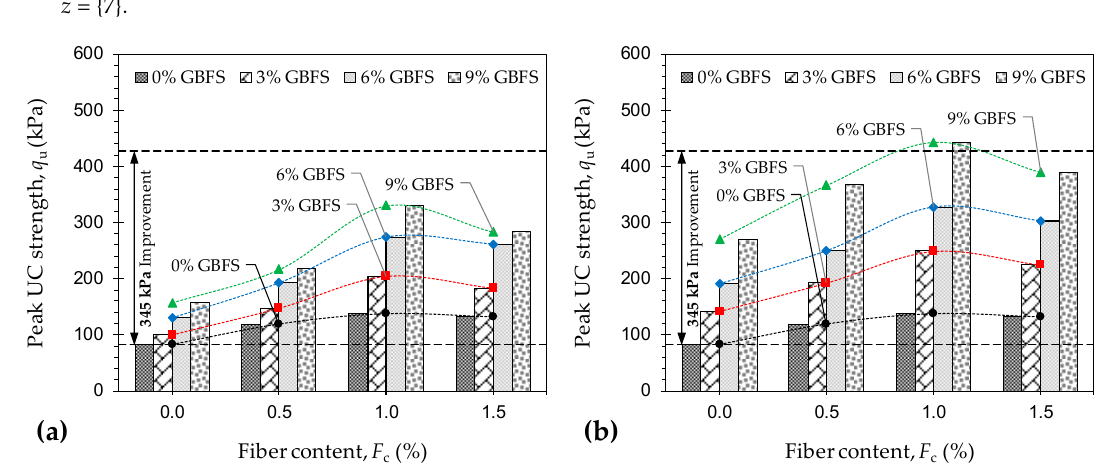
Figure 5. Variations of peak UC strength q u against JF content for the natural soil and various GBFS-treated samples: ( a ) T c = 7 days; and ( b ) T c = 28 days.